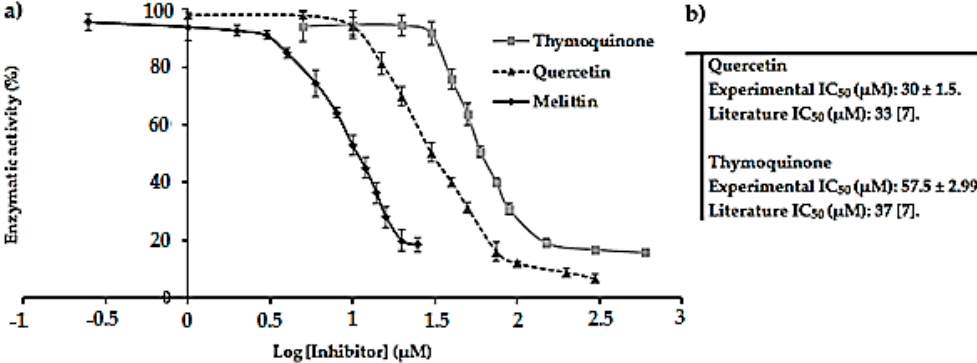
Figure 2. ( a ) Dose-response curve representing the enzymatic activity (%) of E. coli F 1 F 0 -ATPase as a function of the log of the concentration of thymoquinone, quercetin and melittin, respectively. Error bars show the standard deviation obtained from experiments done in triplicate; ( b ) Comparison between the IC 50 values of the reference inhibitors obtained by the developed method and from the literature.